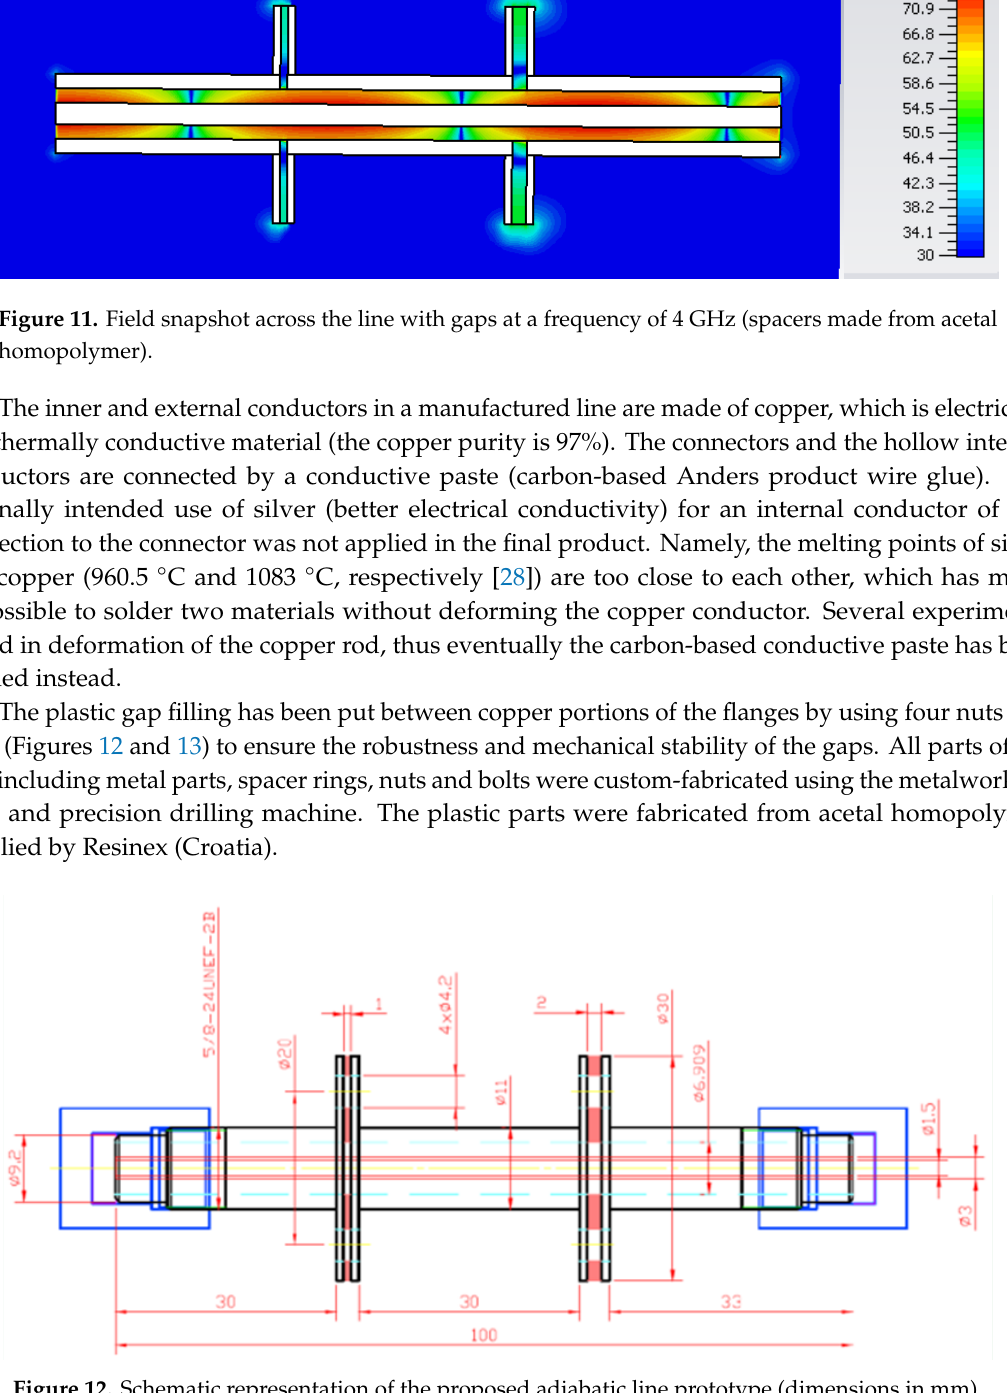
Figure 12. Schematic representation of the proposed adiabatic line prototype (dimensions in mm) .